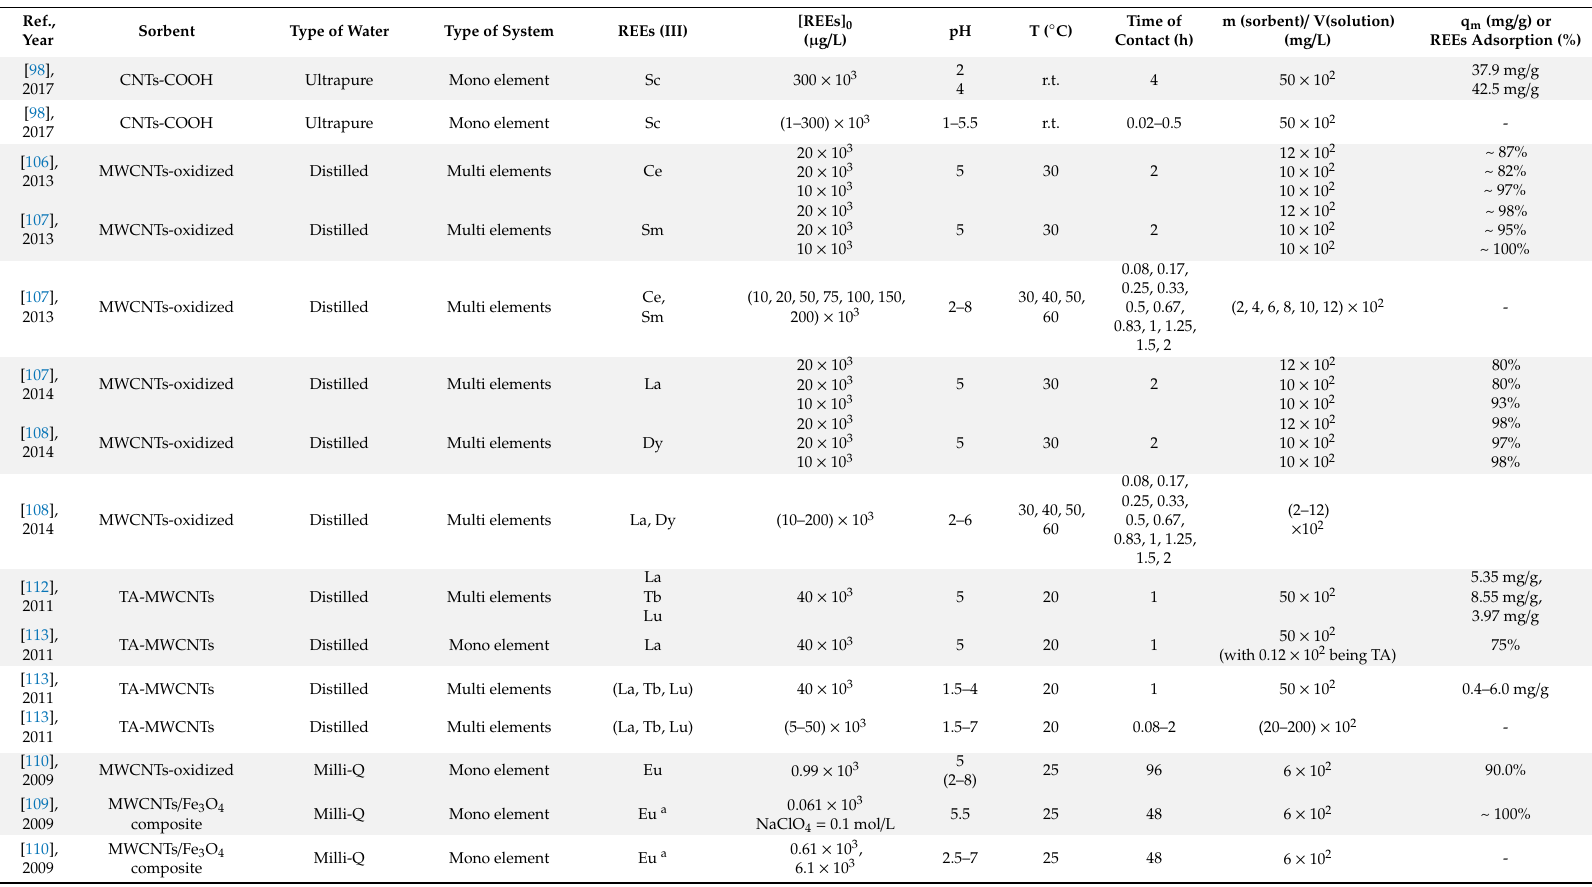
Table 6. Recovery of REEs using CNTs and the respectively experimental conditions used as reported in the